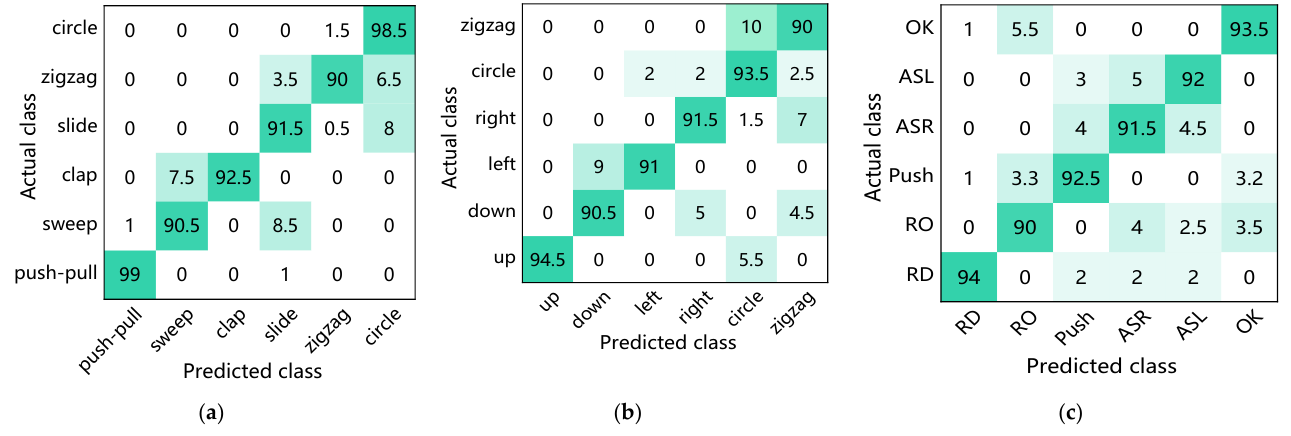
Figure 20. Method performance evaluation: ( a ) Widar3.0 data set validation. ( b ) CSIDA data set validation. ( c ) our data set validation.